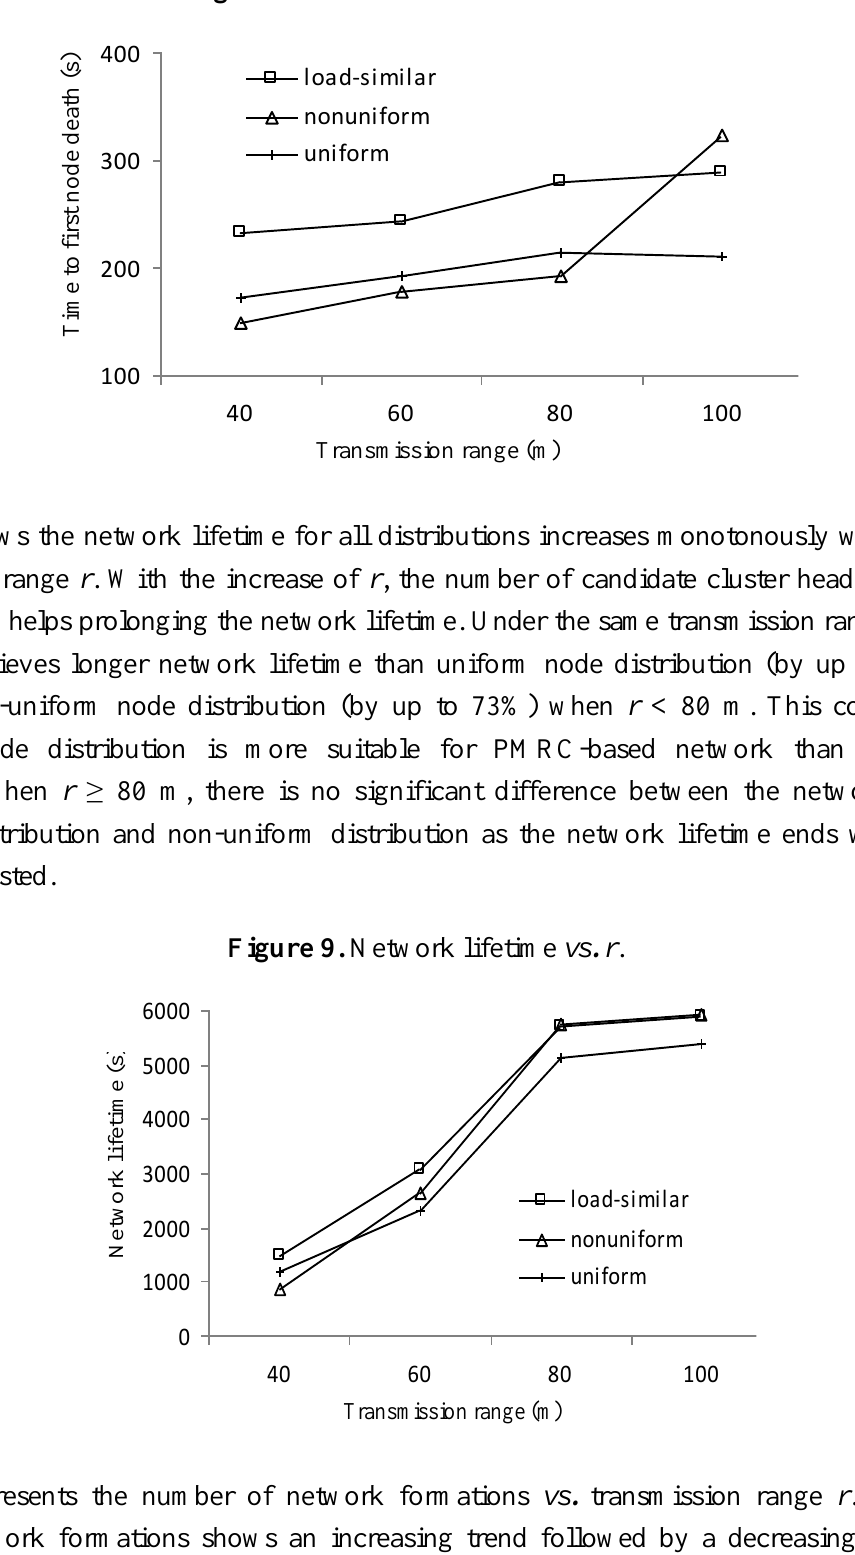
Figure 8. Time to first node death vs. r .